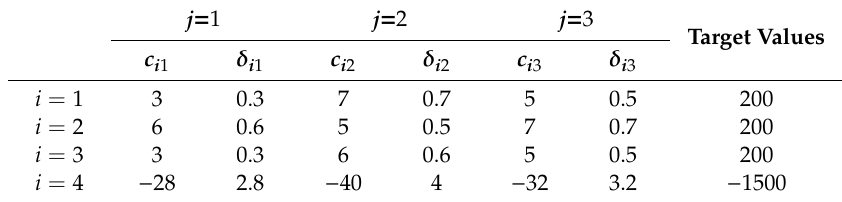
Table 2. Nominal values and possible deviations for each